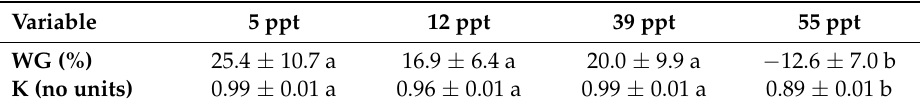
Table 3. Changes in weight gain (WG) and condition factor (K) values in A. regius juveniles acclimated to different environmental salinities (5, 12, 39, and 55 ppt) for 21 days. Data are expressed as the mean ± SEM ( n = 10). Different letters indicate significant differences among groups ( p < 0.05, one-way ANOVA followed by Tukey’s post-hoc